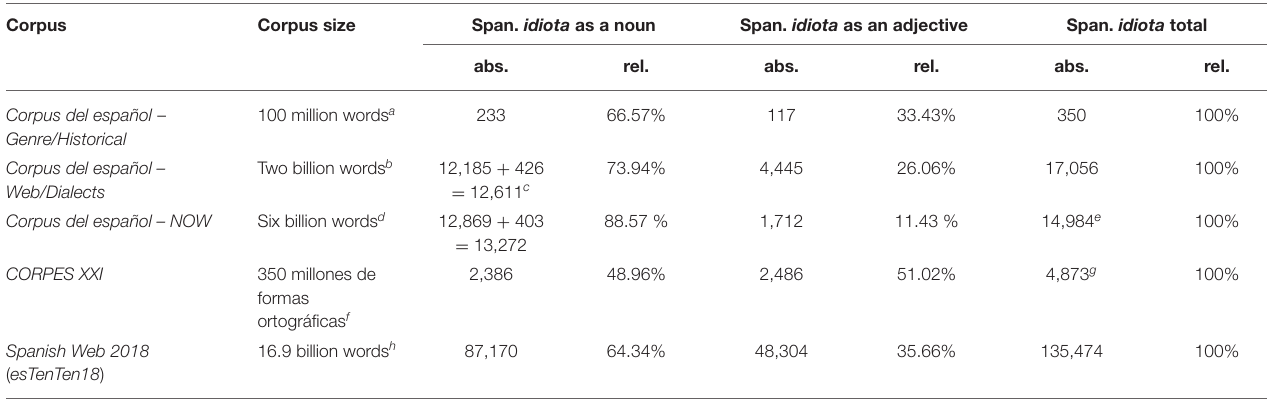
TABLE 8 | Consultation of Spanish online corpora— idiota as noun vs. adjective. Corpus Corpus